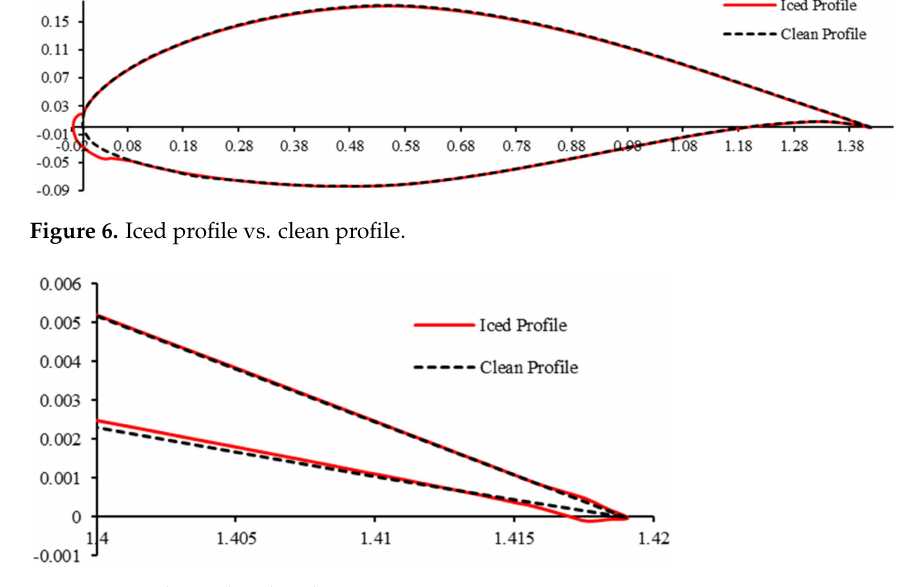
Figure 7. Trailing edge detail.